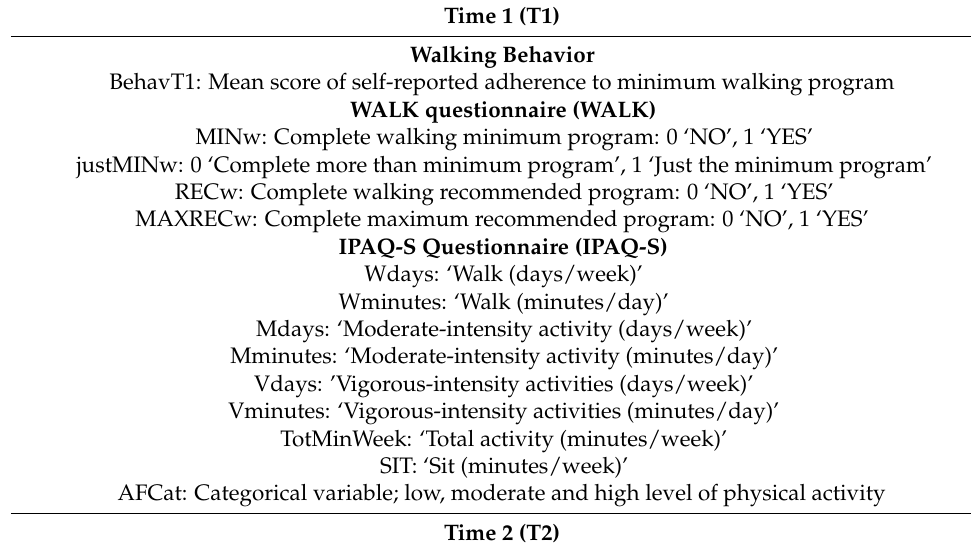
Table 1. Walking measures and